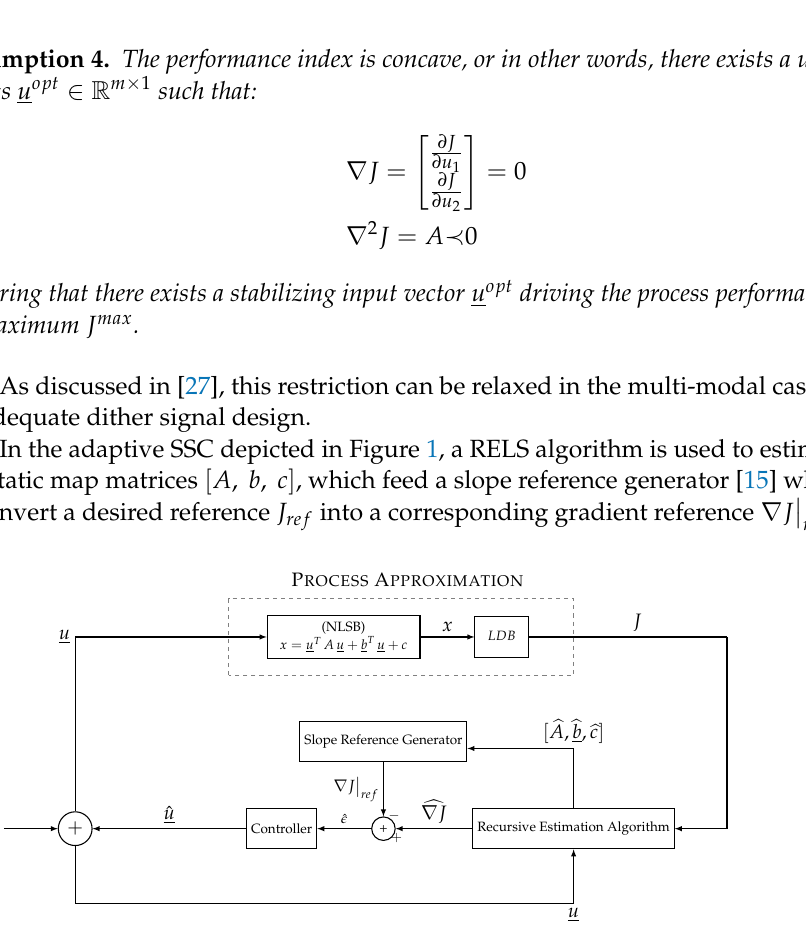
Figure 1. Illustration of the DISO adaptive slope seeking